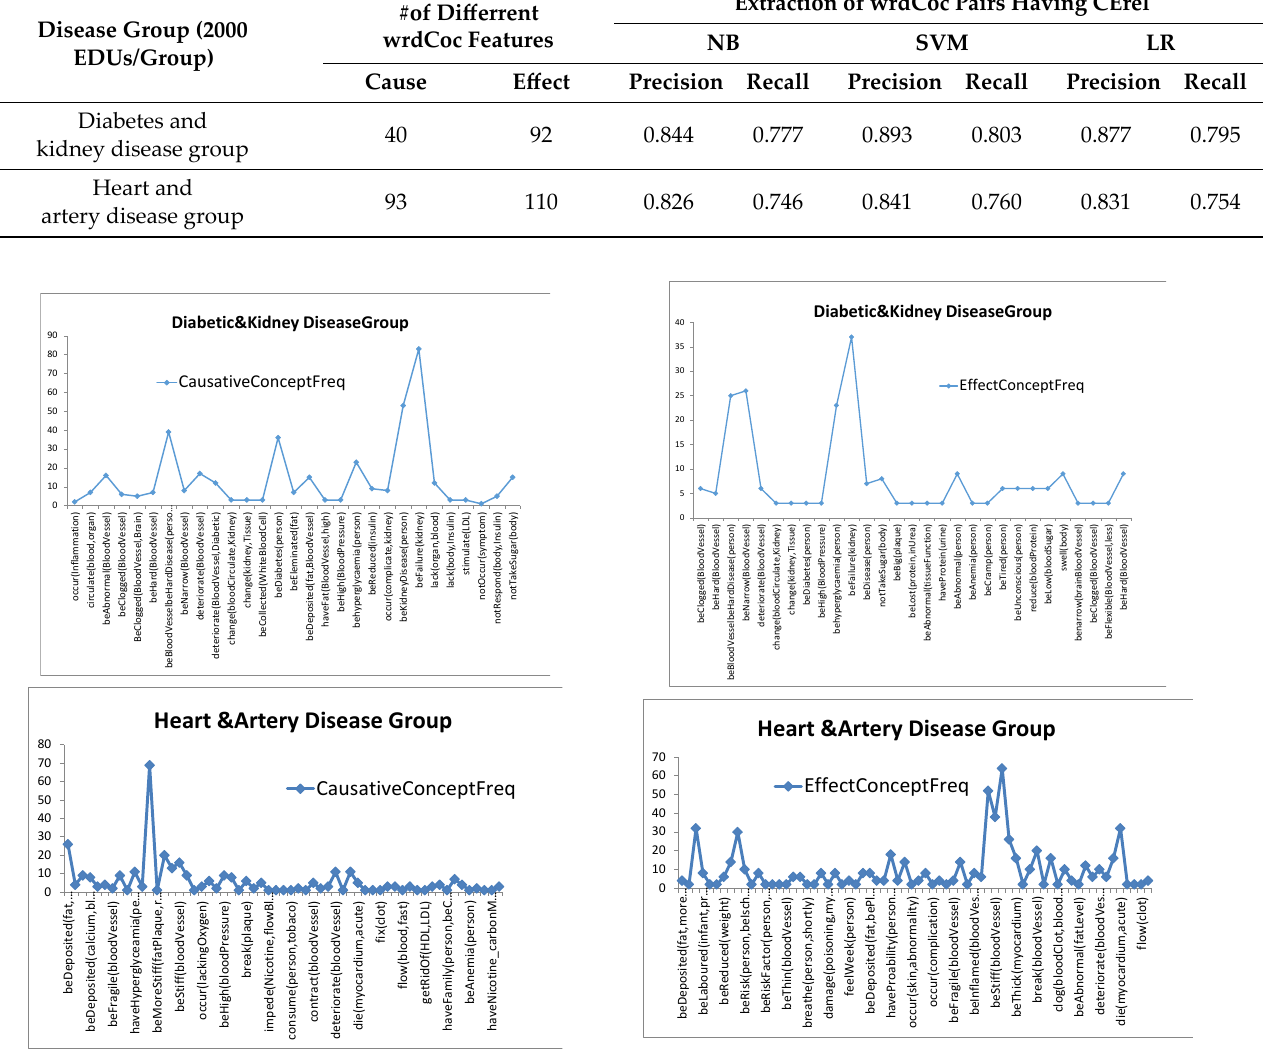
Figure 8. Show the wrdCoc frequencies with the causative concepts and the effect concepts from the diabetes and kidney disease group and the heart and artery disease group.